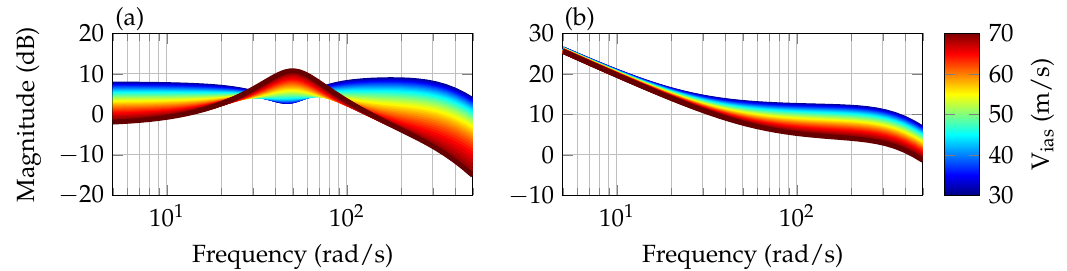
Figure 7. Gain-scheduled SISO controllers W 1 ( V ias ( t )) for the symmetric mode ( a ) and W 2 ( V ias ( t )) for the asymmetric mode ( b ) plotted from 30m/s to 70m/s airspeed.